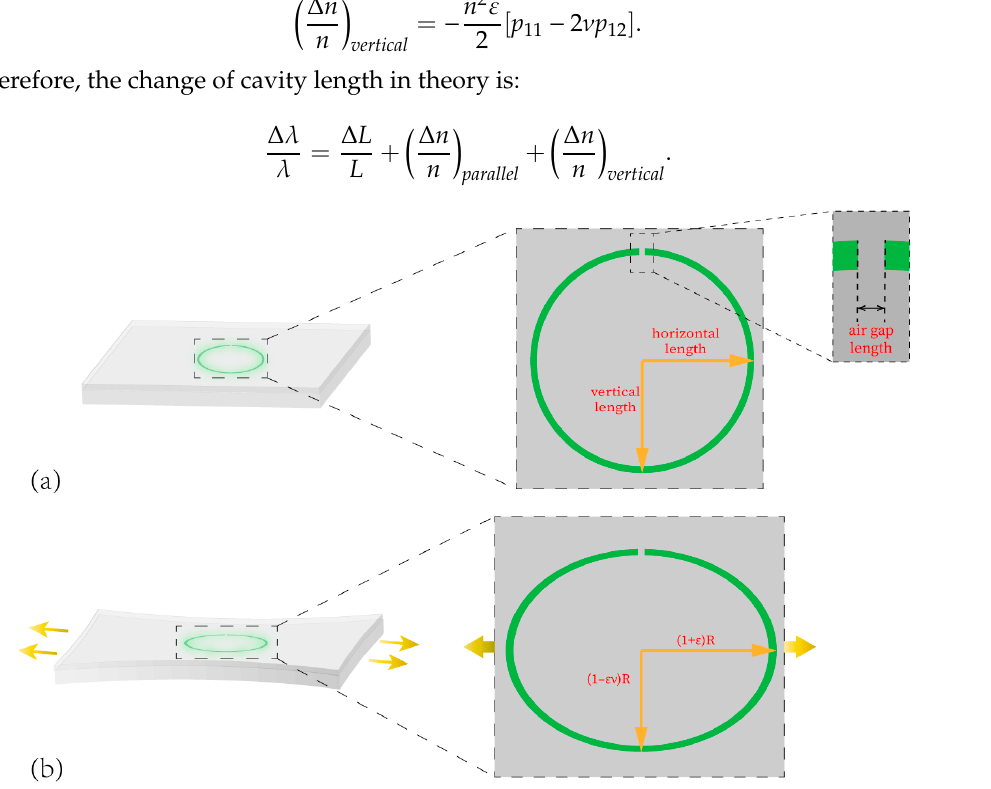
Figure 2. ( a ) Schematic diagram of the nanowire ring cavity. ( b ) Schematic diagram of the nanowire ring cavity under strain ε . ring cavity under strain ε